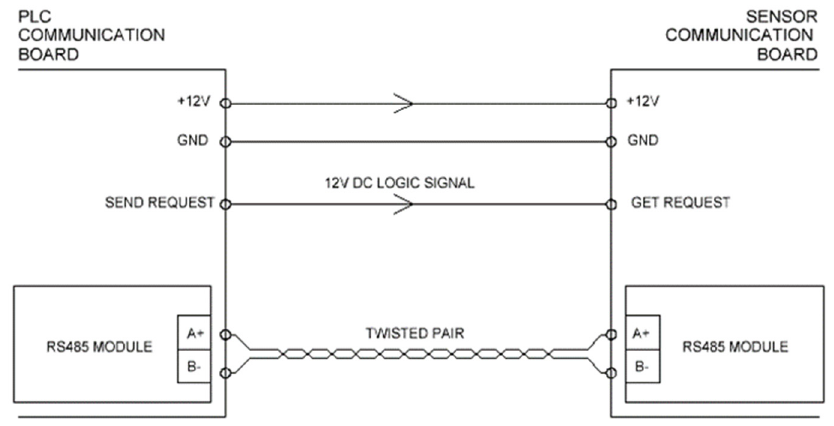
Figure 6. The diagram of data network communication between the sensor modules and the communication board of the main controller.